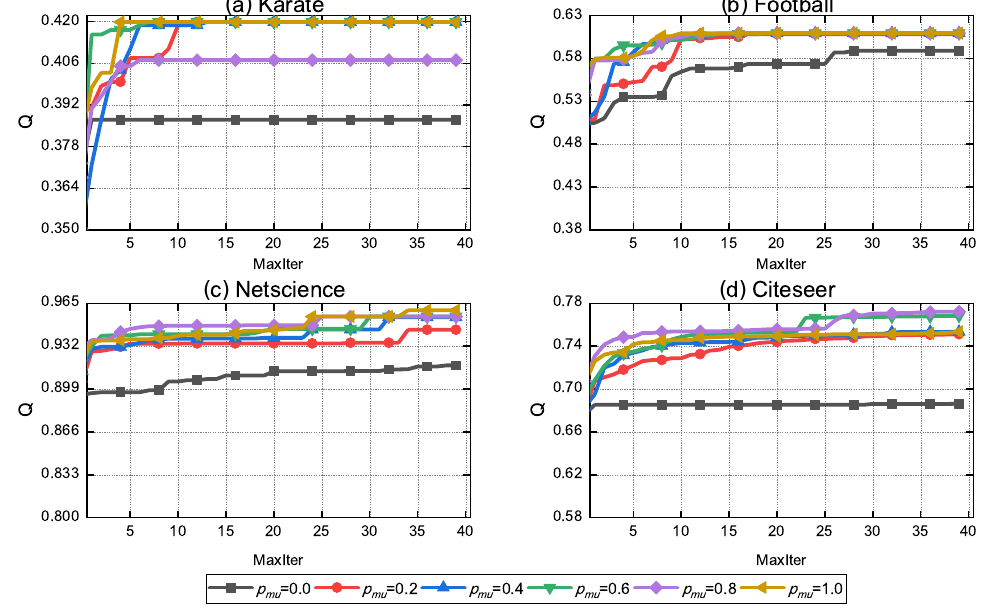
Figure 10. Comparison of Q in different p mu with four real-world